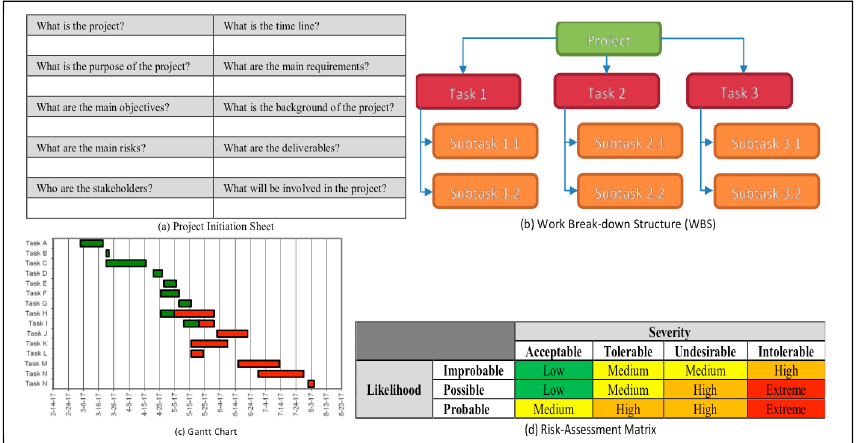
Fig. 1. Project management tools introduced in the course